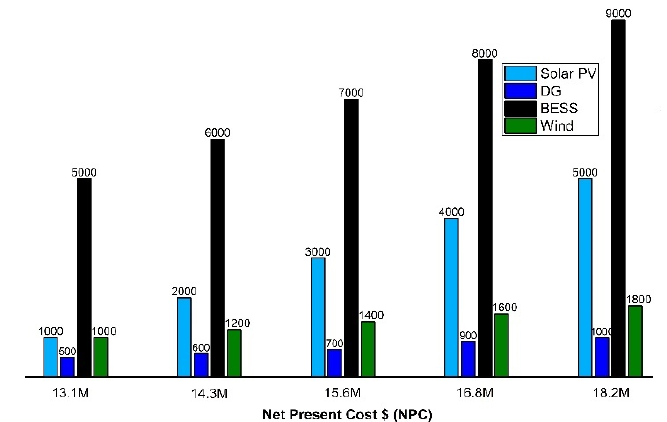
Figure 11. Net present cost for different components used in the system.